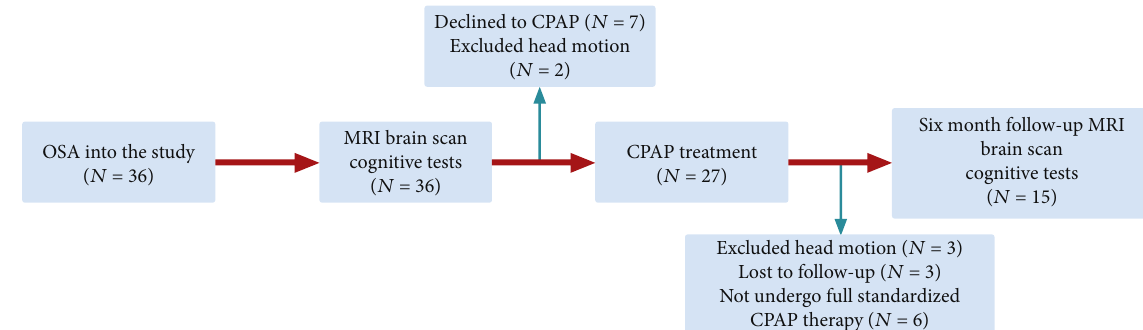
Figure 1: Schematic diagram of OSA patient process in this